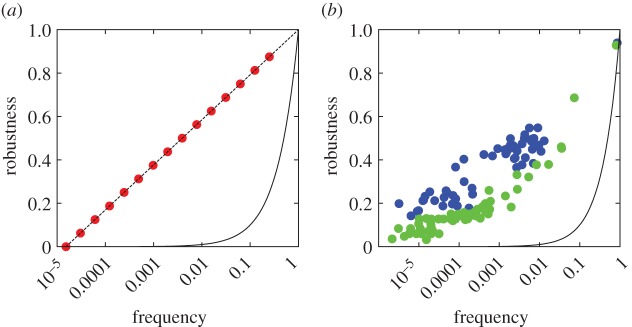
(a) The robustness of phenotypes in the model scales logarithmically with the phenotype frequency and lies far above that expected from randomly distributed phenotypes (solid line). (b) This represents a similar trend to the robustness of RNA (blue) and polyomino (green) phenotypes as a function of their frequency.